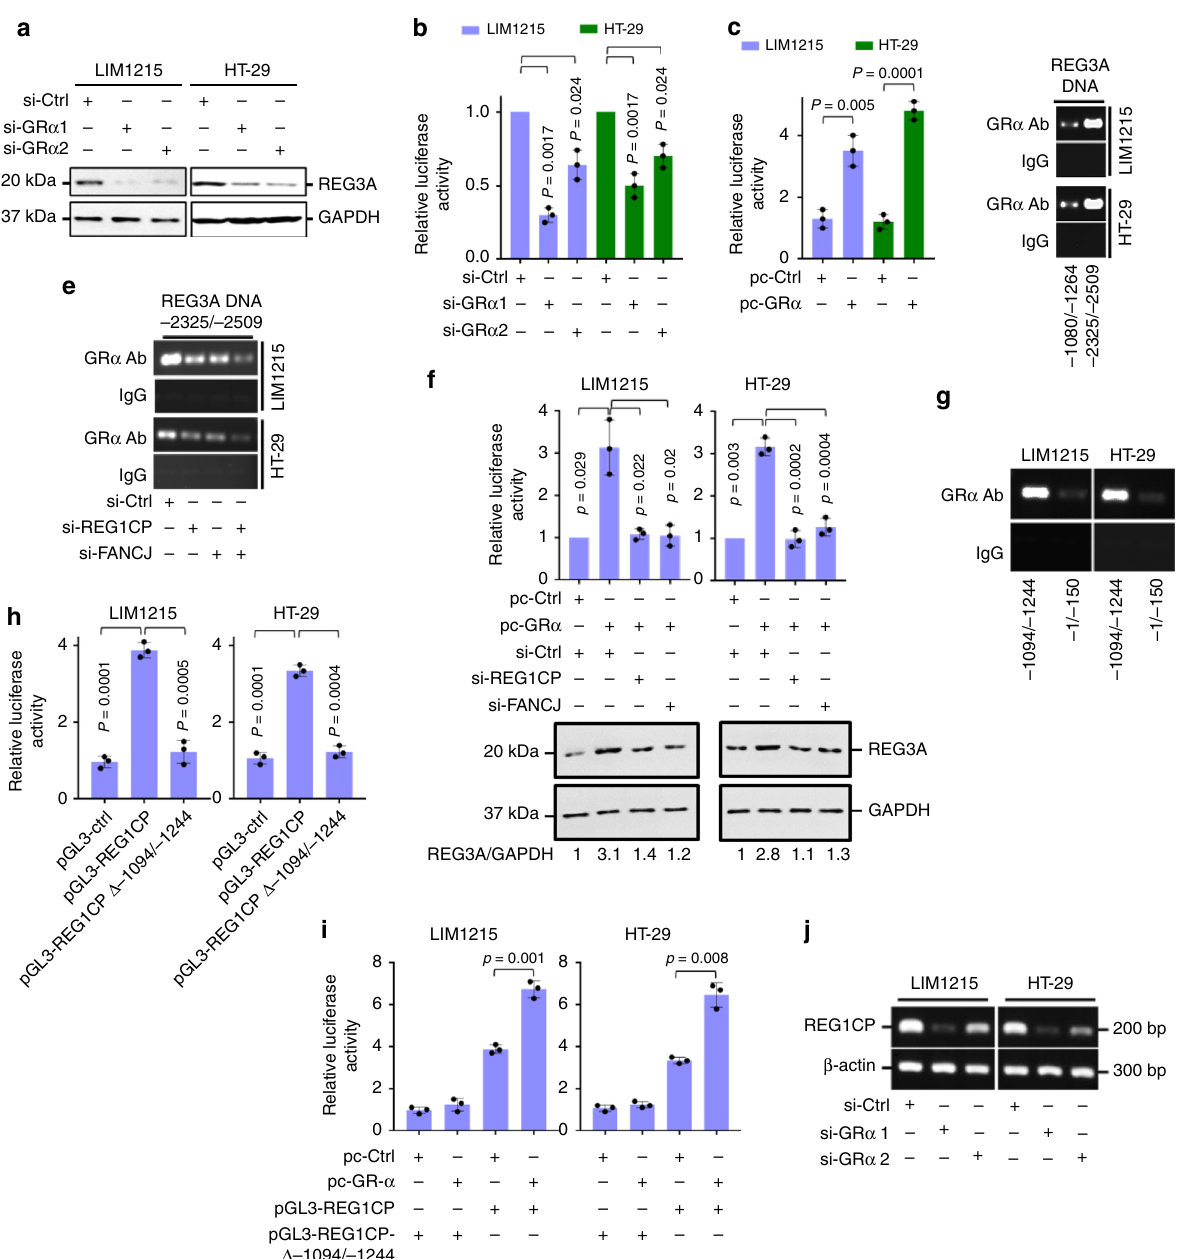
Fig. 7 GR α is responsible for transcriptional activation of REG3A and REG1CP. a GR α silencing reduced REG3A expression. b, c GR α silencing reduced ( b ) whereas its overexpression increased ( c ) luciferase reporter activity of pGL3-basic based REG3 promoter constructs. d GR α bound to the 2325/-2509 fragment of REG3A promoter. The precipitates of an antibody against GR α from formaldehyde-cross-linked chromatin of cells were subjected to qPCR using primers directed to indicated fragments of REG3A promoter. e Silencing of REG1CP or FANCJ reduced the association between GR α and the 2325/-2509 fragment of REG3A promoter as shown using ChIP assays. f Silencing of REG1CP or FANCJ diminished the increase in luciferase reporter activity of pGL3- basic based REG3 promoter constructs (upper) and the upregulation of endogenous REG3A protein levels (lower) caused by overexpression of GR α . The number below each western blot lane represents the level of REG3A protein relative the level of GAPDH expression. g GR α bound to the − 1094/ − 1244 fragment of REG1CP promoter as measured using ChIP assays. h Deletion of the − 1094/ − 1244 fragment abolished luciferase reporter activity of pGL3- basic based REG1CP promoter constructs. i Overexpression of GR α increased luciferase reporter activity of pGL3-basic based REG1CP promoter constructs with the − 1094/ − 1244 fragment. j GR α silencing decreased endogenous REG1CP expression. n = 3 independent experiments. Data are presented as Mean± SEM ( b , c , f (upper), h , i ) or representatives ( a , d , e , f (lower), g , j ). Statistical signi fi cance was calculated using a two-tailed t